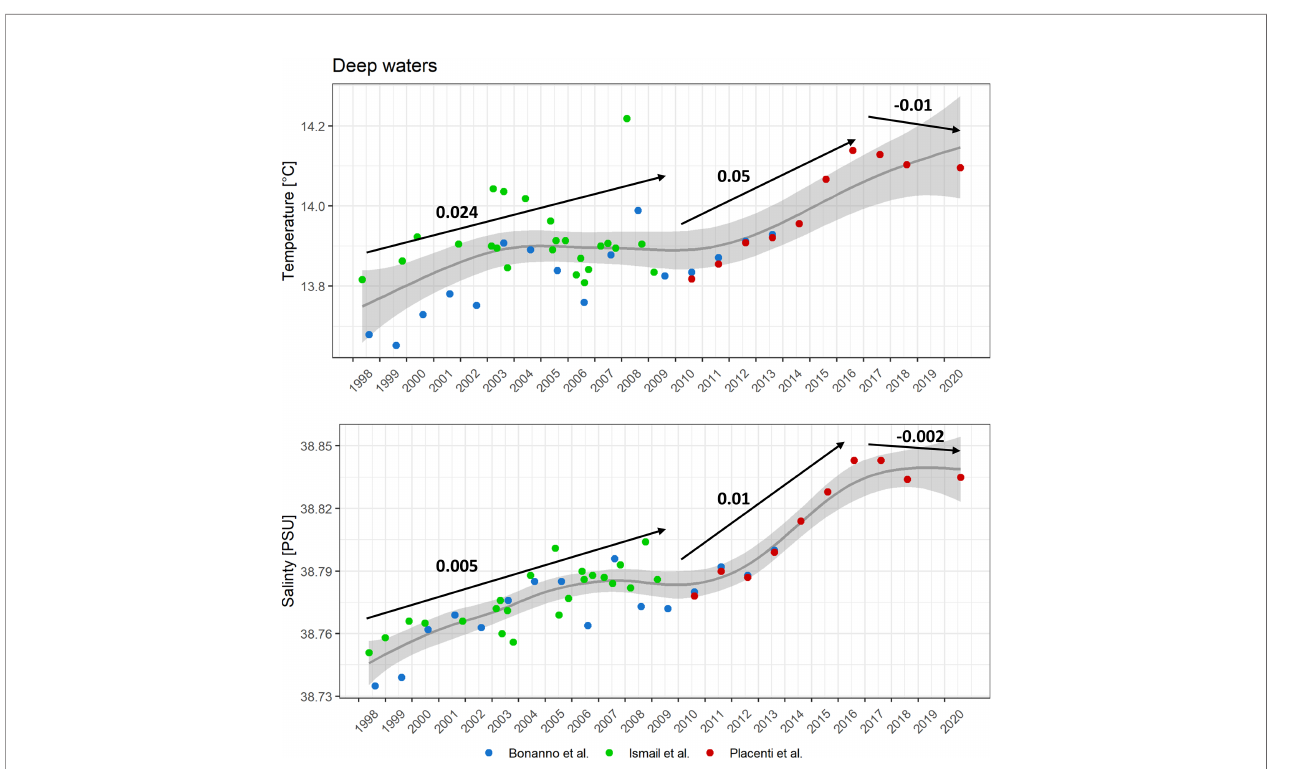
FIGURE 8 | Potential temperature (top panel) and salinity (bottom panel) time series of the DW, extrapolated by Ben Ismail et. (2014), Bonanno et al. (2014) and this study are indicated as green, blue and red dots, respectively. A cubic regression spline computed through a GAM model and the relative con fi dence interval has been added in gray with the aim at evidencing temporal trends. Black arrows indicate the average annual increments of hydrological parameters computed for 1998- 2009 by Bonanno et al. (2014) and for 2010-2020 from data collected in this study. The position of the dots on the time axis takes depend on the sampling